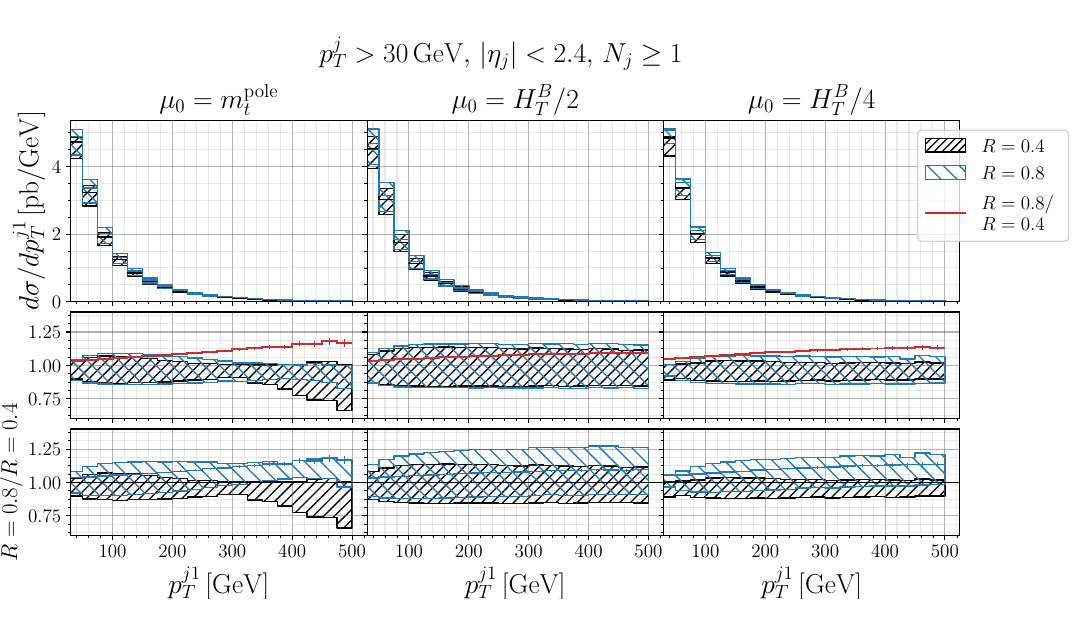
Figure 29 . Same as figure 27, but for the p j 1